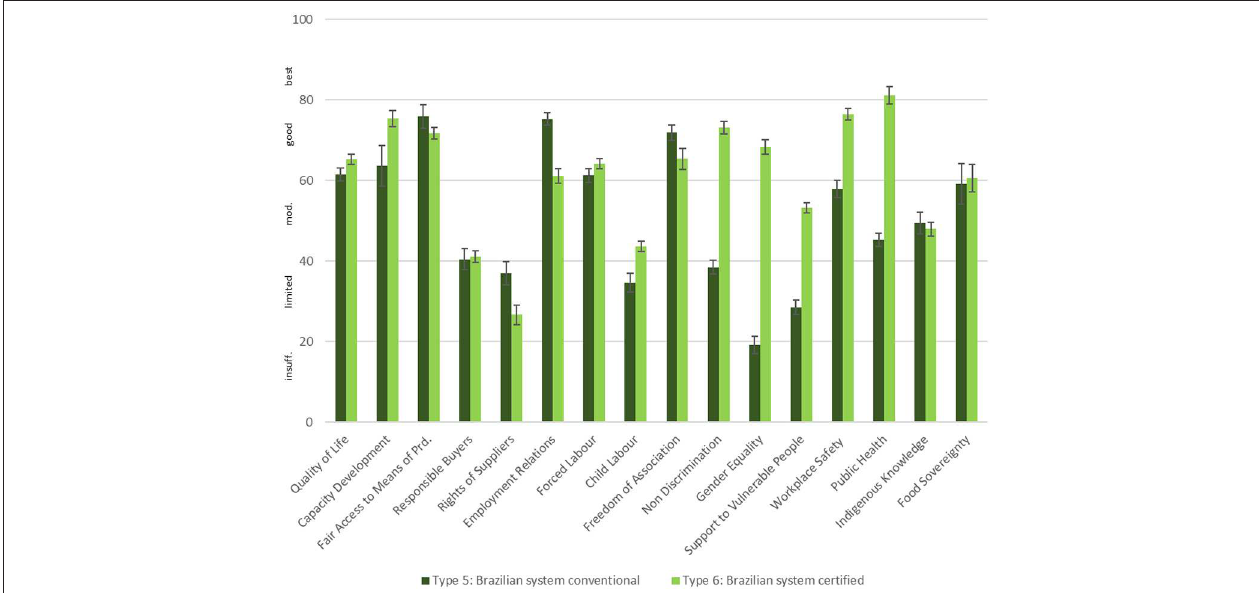
FIGURE 7 | Sustainability performance of typical Brazilian coffee production systems for “Social Well-Being”.